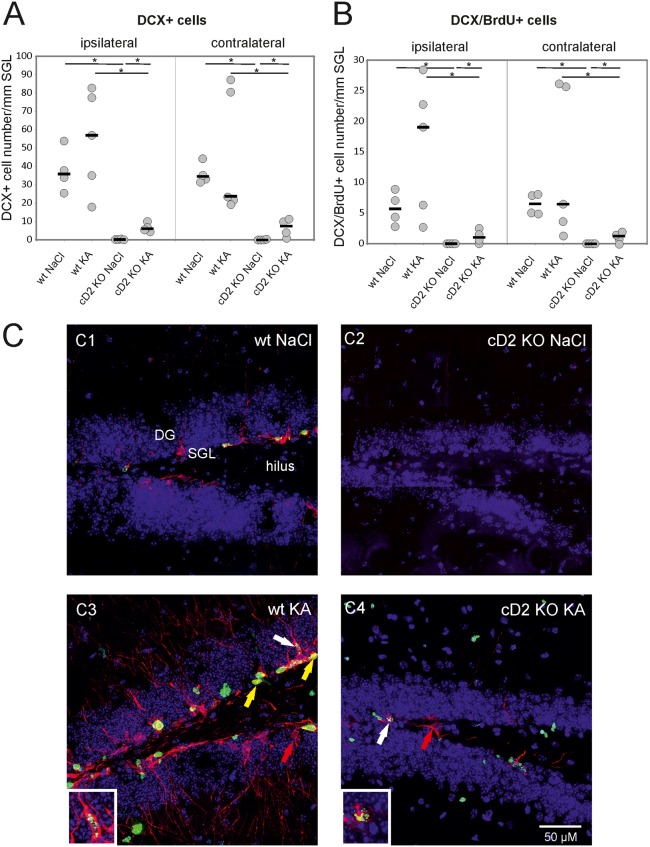
Kainic acid-induced early neurogenesis in the dentate gyrus of wt and cD2 KO mice.
(A) Number of DCX+ cells/mm of subgranular layer of the ipsilateral and contralateral dentate gyrus. (B) Number of DCX/BrdU+ cells/mm of subgranular layer of the ipsilateral and the contralateral dentate gyrus. Each circle represents one animal and horizontal bars indicate median values. (C) Representative BrdU (green) and DCX (red) double immunostaining in wt and cD2 KO mice following NaCl (C1, C2, respectively) or kainic acid injection (C3, C4, respectively); * p<0.05 of Mann Whitney U test; yellow arrow—double stained, DCX/BrdU+ cells; red arrow—DCX+/BrdU- cells; white arrow and inserts in C3 and C4—DCX/BrdU+ cells with fragmented nucleus indicating apoptosis; cD2—cyclin D2; DCX—doublecortin; BrdU—5-bromo-2'-deoxyuridine; DG—dentate gyrus; SGL—subgranular layer; KO—knock-out; wt—wild type.